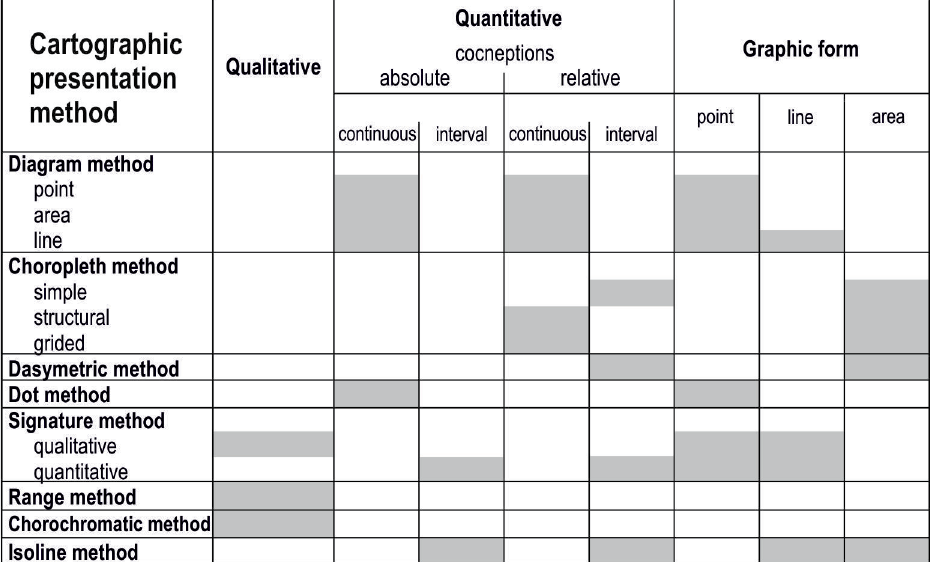
Table 1. “Table of the properties of cartographic methods” (according to L. Ratajski and B. Winid